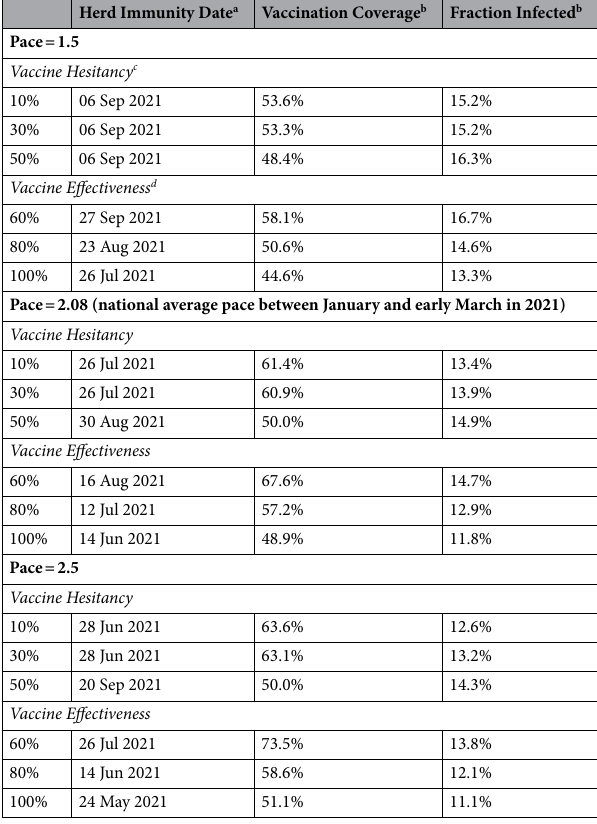
Table 1. Predicted herd immunity with different vaccination pace, vaccine hesitancy, and vaccine effectiveness estimates. a Estimated week when herd immunity is achieved. The date mentioned in each row marks the first day of the week. b Cumulative values when herd immunity is achieved. c Percentage of the population who are hesitant to get the vaccine. d Population-level effectiveness of the first dose of COVID